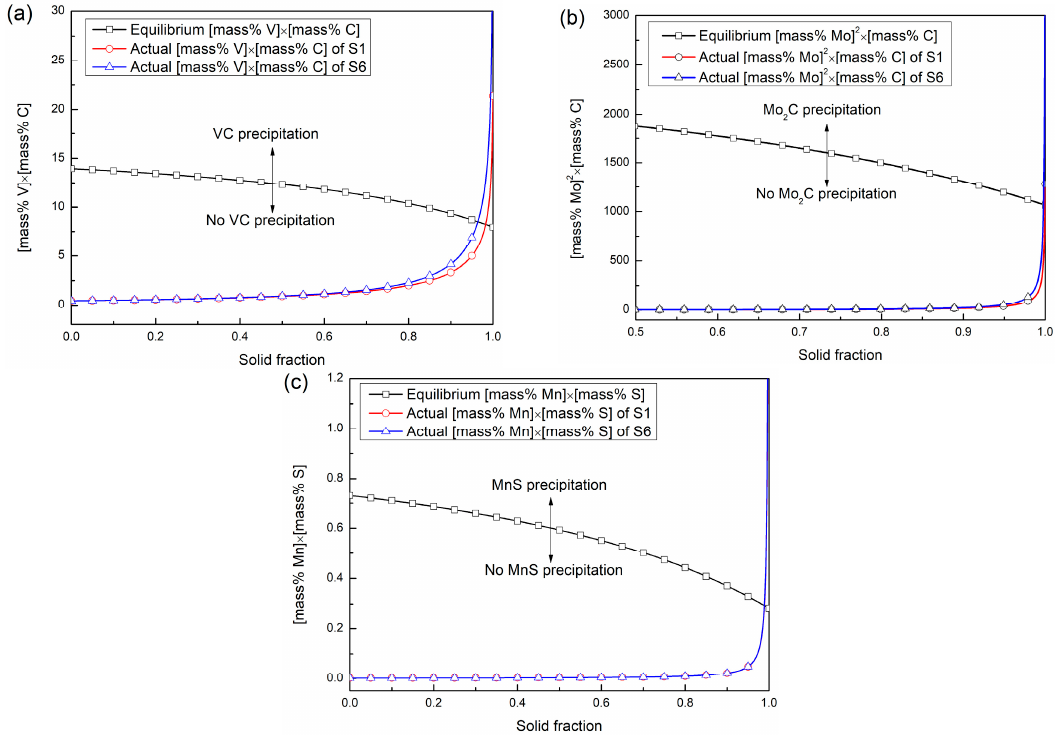
Figure 9. Relationship between element concentration product and solid fraction: ( a ) elements V and C, ( b ) elements Mo and C, and ( c ) elements Mn and S (online version in color).